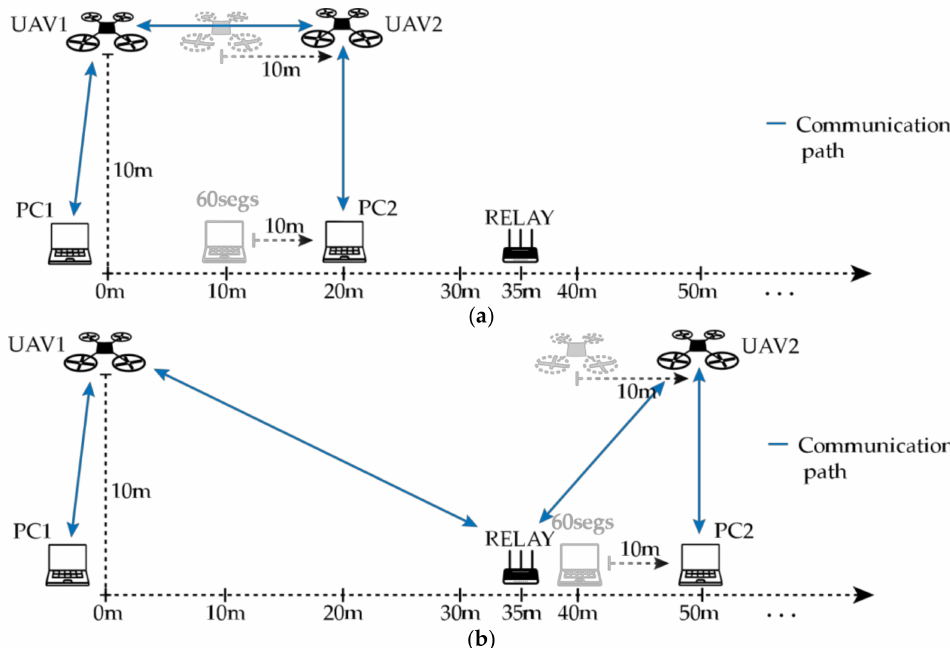
Figure 2. Real testbed FANET with relay node. ( a ) Communication before 35-m mark. ( b ) Com- munication after 35-m mark. Note that after the 35-m mark, communication between the 2 UAVs (UAV1 and UAV2) was performed through the relay node. Before this mark, the communication was completed through a direct path. Performance measurements were taken between the 2 UAVs every 10 m step and each measurement had a duration of 60 s. The PCs were used to monitor the network and followed their UAV. The height of the UAVs was 10 m. The first UAV (UAV1) was located at the 0-meter mark. The relay node was located at the 35-m mark. The second UAV (UAV2) was positioned for 60 s at the measurement points located 10 m from the 0-meter mark. That is, the first measuring point was located at 10 m, the second at 20 m, and so